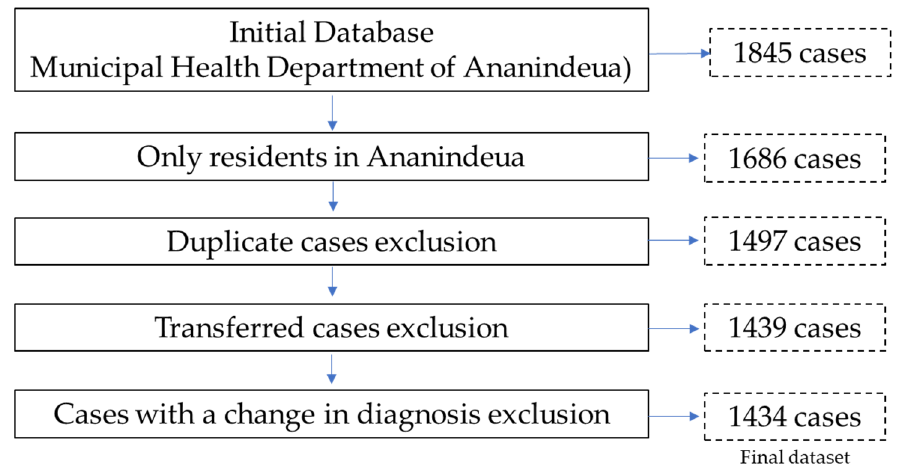
Figure 2. Population screening for the study. Tuberculosis, Ananindeua/Pará, 2018 to 2022. Data source: SINAN.